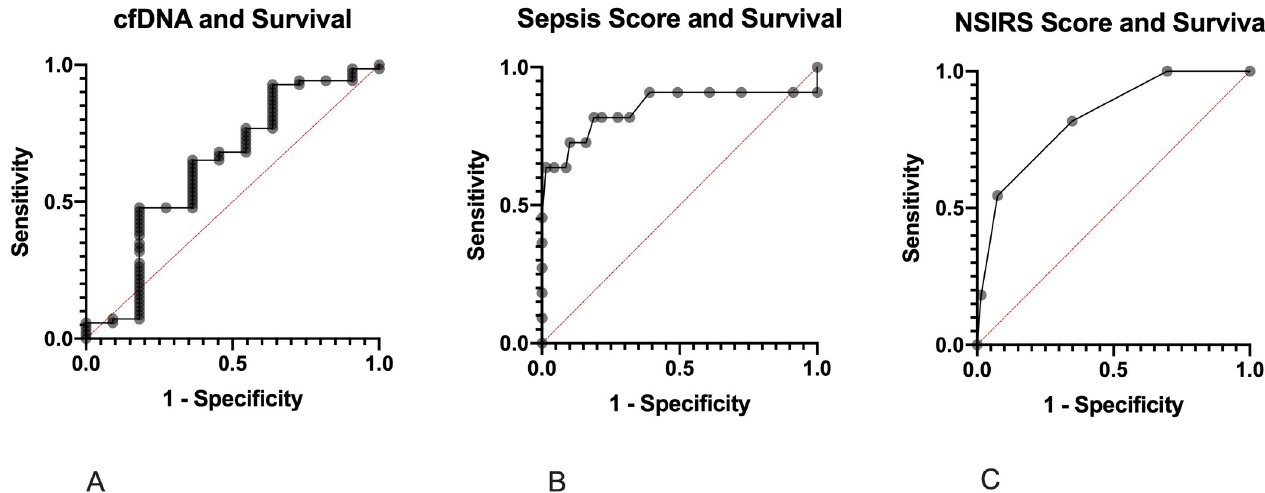
Fig 5. Receiver operator characteristic (ROC) curves for cfDNA (A), sepsis score (B) and NSIRS score (C) for predicting survival in 80 hospitalized neonatal foals.